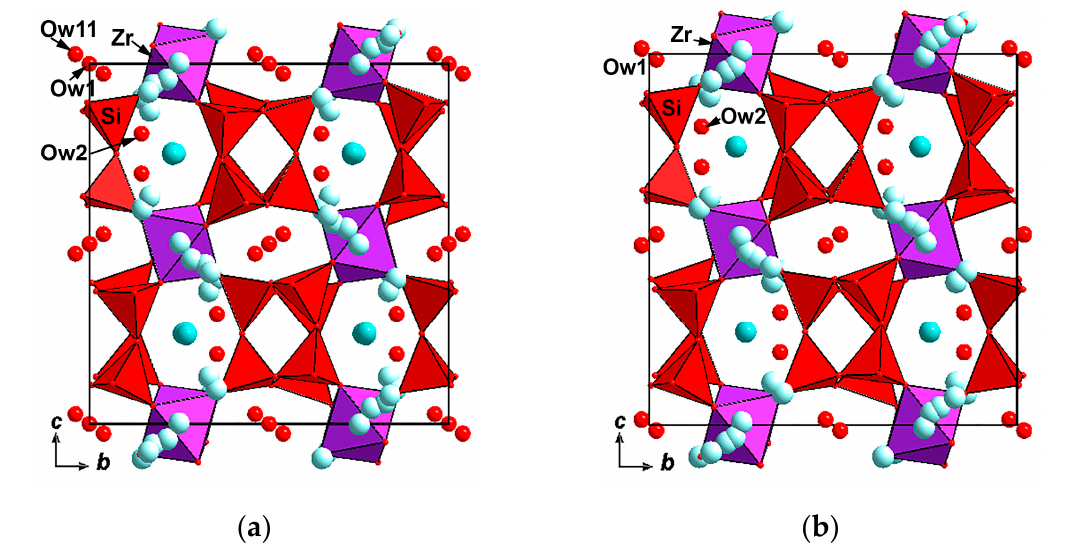
Figure 5. The crystal structures of Ag-exchanged forms of elpidite projected along the a axis: Sample I ( a ) and Sample II ( b ). The Ag1 site and its sub-sites are light blue circles; the Ag2 site and its subsites ( I ) are blue circles. The unit cells are outlined.